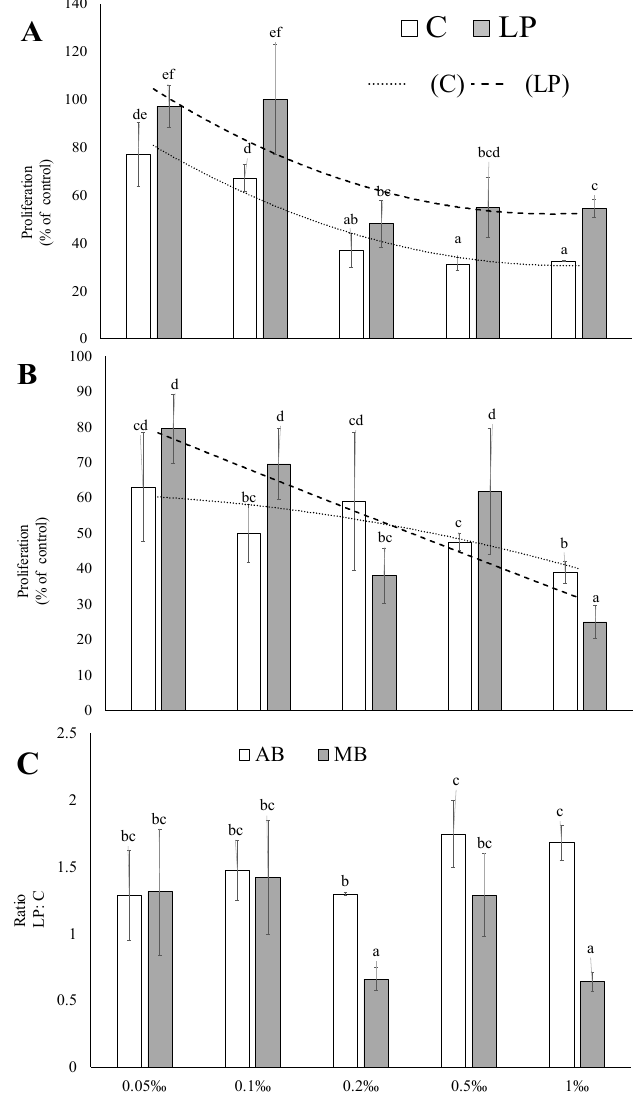
Figure 3. Effects of the digest on the proliferation of the AGS line. ( A ) Adzuki bean sprouts, ( B ) mung bean sprouts, and ( C ) the probiotic-rich sprouts vs. the control. Bar graphs depict the averaged AGS proliferation (control = 100%). Means ( ± SD) for the selected activity followed by different letters are significantly different ( n = 9; p ≤ 0.05). C—control sprouts and LP—sprouts enriched with Lactobacillus plantarum .